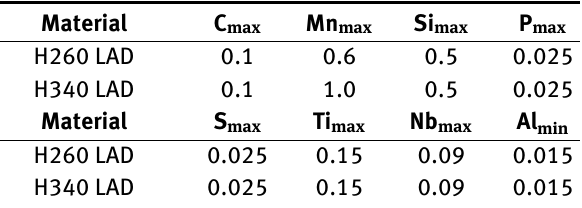
Table 1: Chemical composition of observed materials (in wt-%). Table 2: Basic mechanical properties of observed